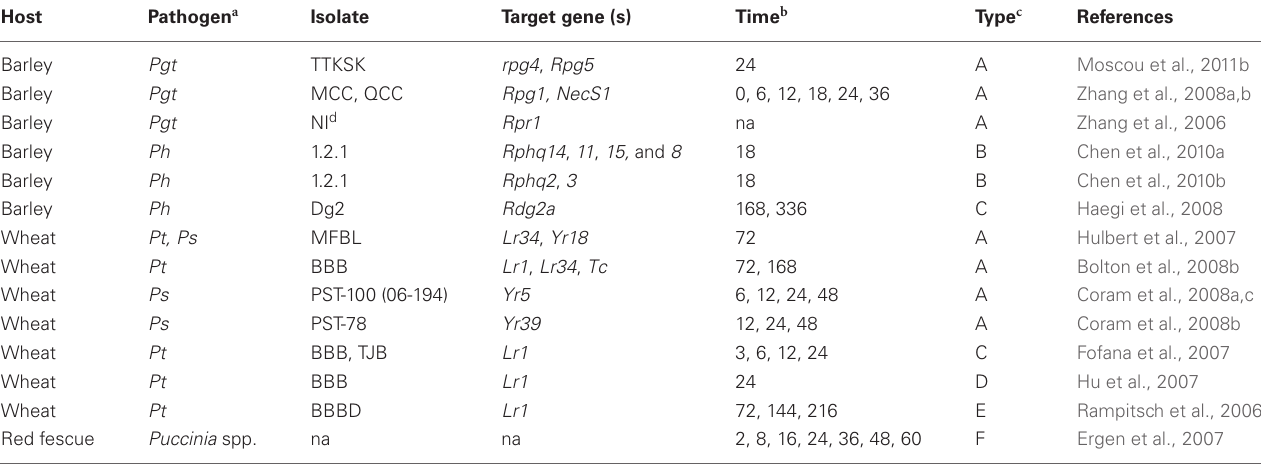
a Pathogen abbreviation: Pgt, P. graminis f. sp. tritici (Stem Rust); Pt, P. triticina (Wheat Leaf Rust); Ps, P. striiformis (Stripe Rust); Ph, P. hordei (Barley Leaf Rust). b Time, hours after inoculation. c Type of technique used for data obtaining: A, Affymetrix GeneChip; B, Agilent oligonucleotide array; C, cDNA microarray; D, cDNA library; E, Proteomic; F,